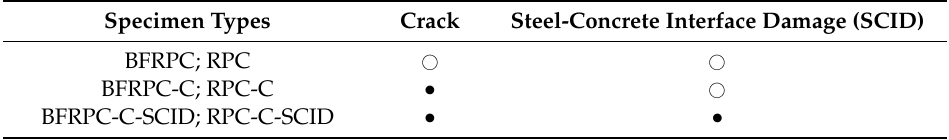
Table 3. Description of specimen